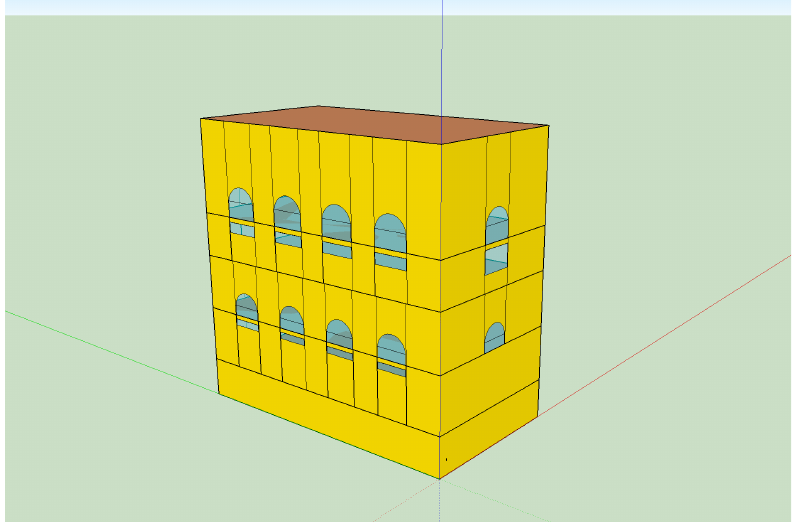
Figure 4. Model of the